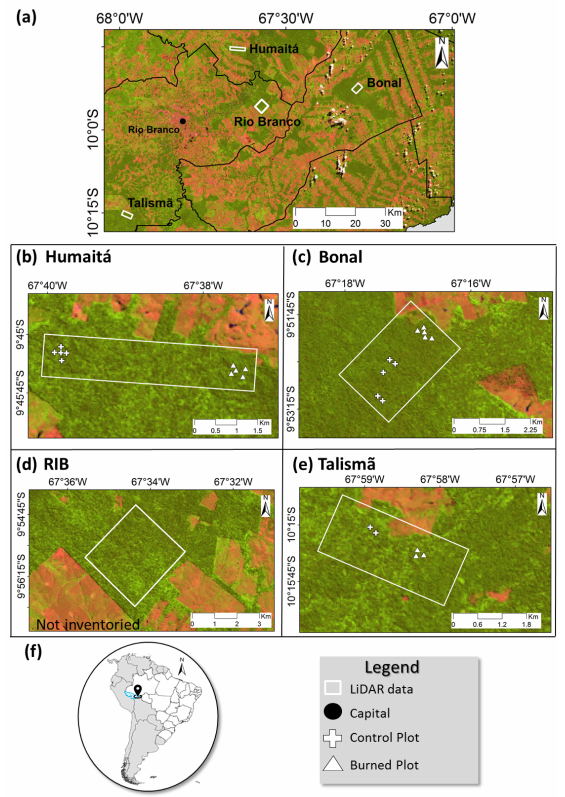
Figure 1. ( a ) the composition map (Red/Green/Blue = Band 5/4/3) of Landsat-5 Thematic Mapper (TM) images of the study area; ( b ) Humaitá; ( c ) Bonal; ( d ) Rio Branco; ( e ) Talismã; and ( f ) map of the studied region. The white polygons (in b – e ) represent the LiDAR covered. The blue polygons are the plots not affected by fire and the red polygons are the plots affected by